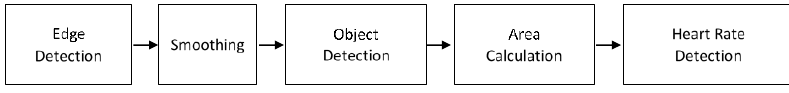
Figure 2. Procedure of the fingertip curve line movement-based detection method.